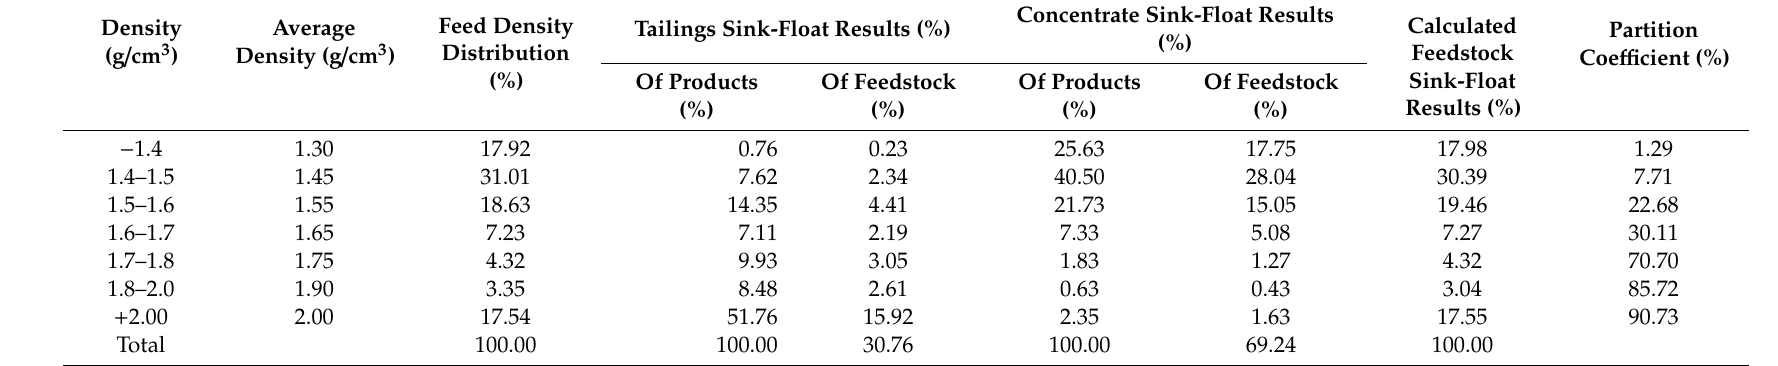
Table 10. Partition coe ffi cient results of − 6 + 1 mm fine coal for compound dry